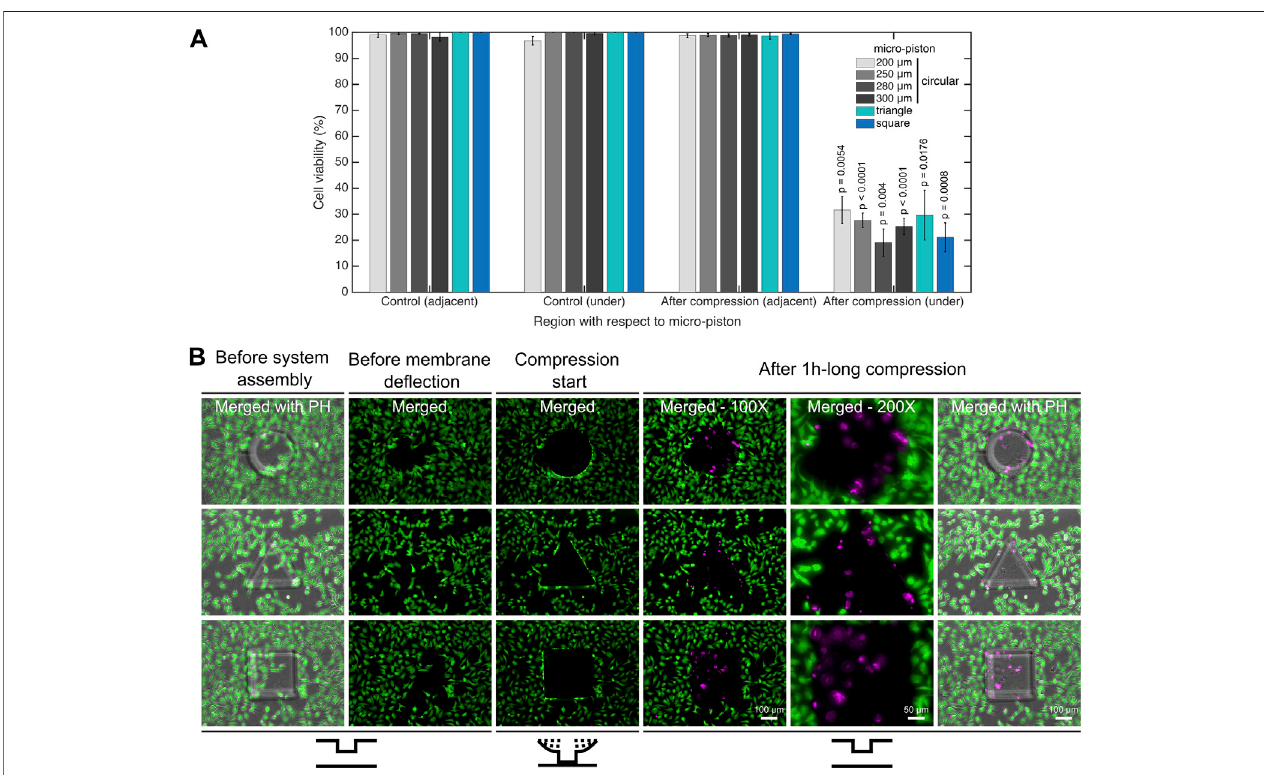
FIGURE 4 | Cell viability for mechanical compression and lysis. (A) Cell viability decreased from on average 99.4% to 25.8% under the micro-pistons of 200, 250, 280, and 300 µm diameter circular, triangle, and square shapes (1 h compression, 640 mbar) compared to noncompressed (control) devices ( n (cid:2) 25 devices at static state (noncompressed); n (cid:2) 25 devices with dynamic compression). The cells within the periphery of the micro-piston, which had part of their body under the micro- pistonarea,werecounted intothegroupof “ underthemicro-piston ” .Allothercellsinthe fi eldofview(FoV),outsideofthemicro-pistonperiphery,werecountedas “ adjacent to micro-piston ” . (B) Dynamic compression on SKOV-3 cancer cells, mechanical cell lysis and an illustration for patterning the cell monolayer by stamping the particular shapeofthemicro-pistonascircular,triangleorsquare.Cellsandtheirviabilityweremonitored beforethedevicewasconnectedtothe pressuresupplyunitof the compression system (1st column); before membrane de fl ection (2nd column); when membrane was de fl ected and compression started at 640 mbar (3rd column); after 1-h-longcompression wasappliedwithdifferentshapes ofmicro-pistons onSKOV-3cells and micro-pistonpositionwas recovered (4 – 6th columns).Aftersystem assembly, and before membrane de fl ection and compression were started, the cell viability solution was replaced with cell culture media. Live cells retained their calcein AM signal since the dye entered the cells and was hydrolyzed inside. Once the compression was complete and the micro-piston was retracted to its initial position, the cell culture chamber was reloaded with cell viability solution for staining the dead cells. Live cells (green) and dead cells (magenta) were imaged with calcein AM and ethidium homodimer-1 (EthD-1) epi- fl uorescence and merged with phase-contrast images. Merged: merged form of the calcein AM and EthD-1 epi- fl uorescence images; merged with PH: merged form of the epi- fl uorescence images with the corresponding phase-contrast (PH)